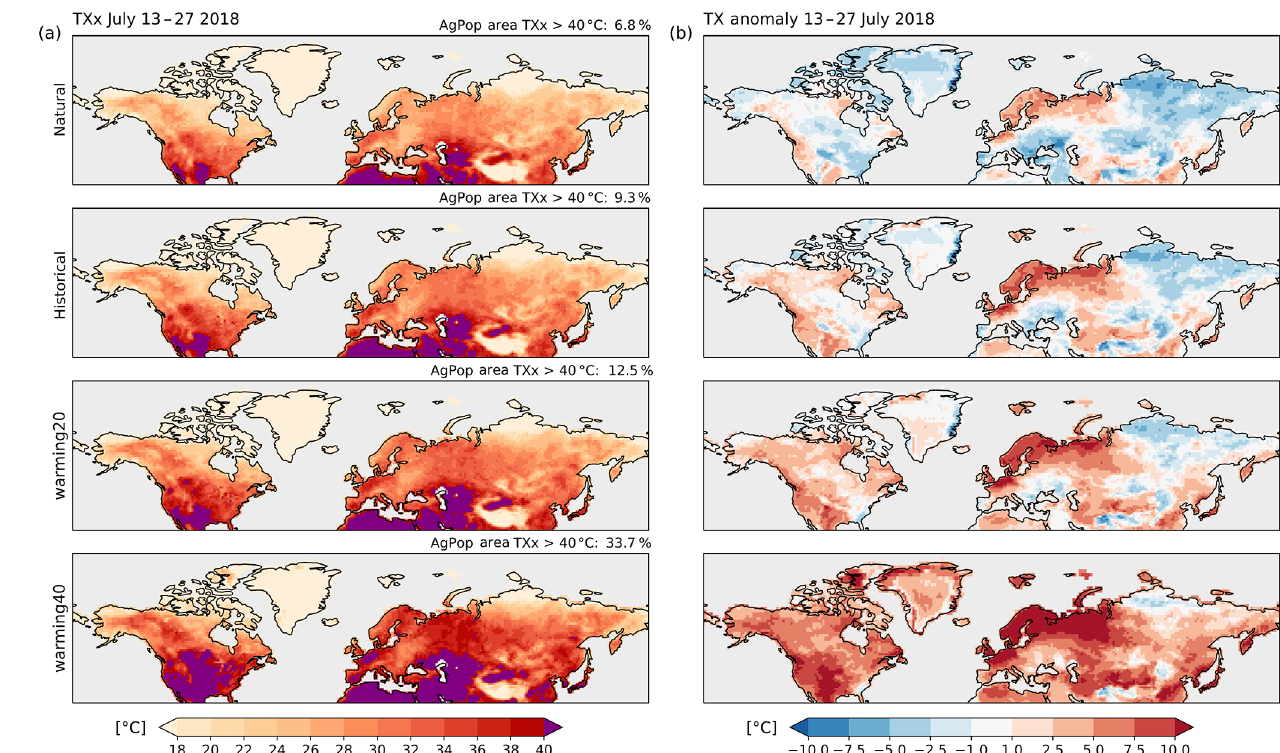
Figure 4. Daily maximum temperatures (TX) for 13 to 27 July 2018. (a) Bias-corrected absolute maximum TX (TXx) over the 15 d period. The number in the upper right corner indicates the fraction of the AgPop region where absolute temperatures exceed 40 ◦ C. (b) Anomaly of mean TX over the 15d period compared to the 1981–2010 historical climatology (no bias correction).